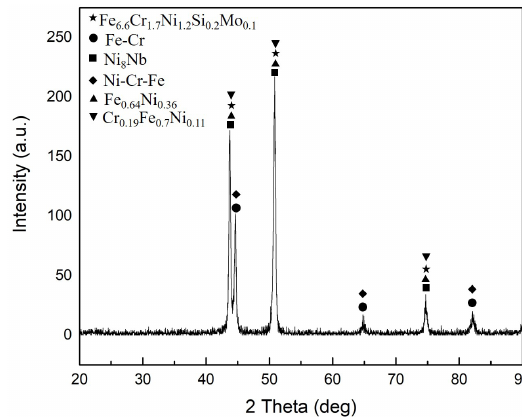
Figure 5. XRD of fusion zone.